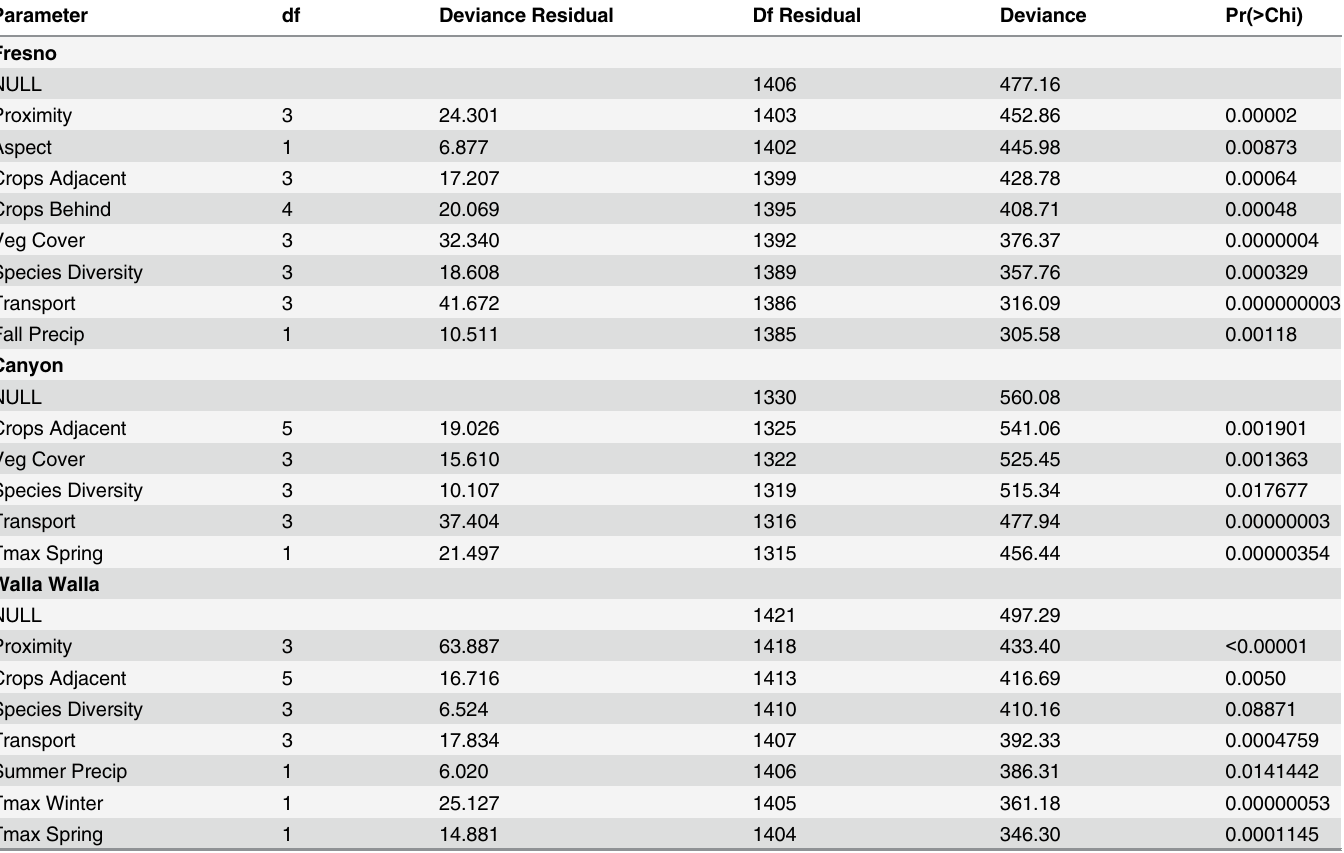
Table 4. Stepwise logistic regression model for the influence of alfalfa production area, cropping pattern, roadside verge characteristics, transport spillage and climate on the occurrence of roadside alfalfa populations.